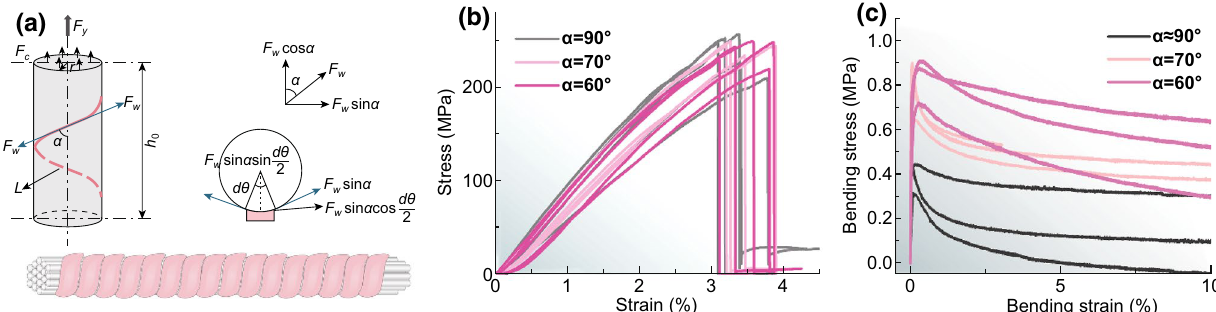
Fig. 3 Geometrical and structural design of SF/SSF and PTFEF/SSF yarns for mechanical optimization: a Schematic illustration of geometry and forces acting on a warping pitch of co-wrapped yarn. b Stress–strain curves of SF/SSF yarns with different wrapping angles of shell SF yarns. c Bending stress–bending strain curves of SF/SSF yarns with different wrapping angles of shell